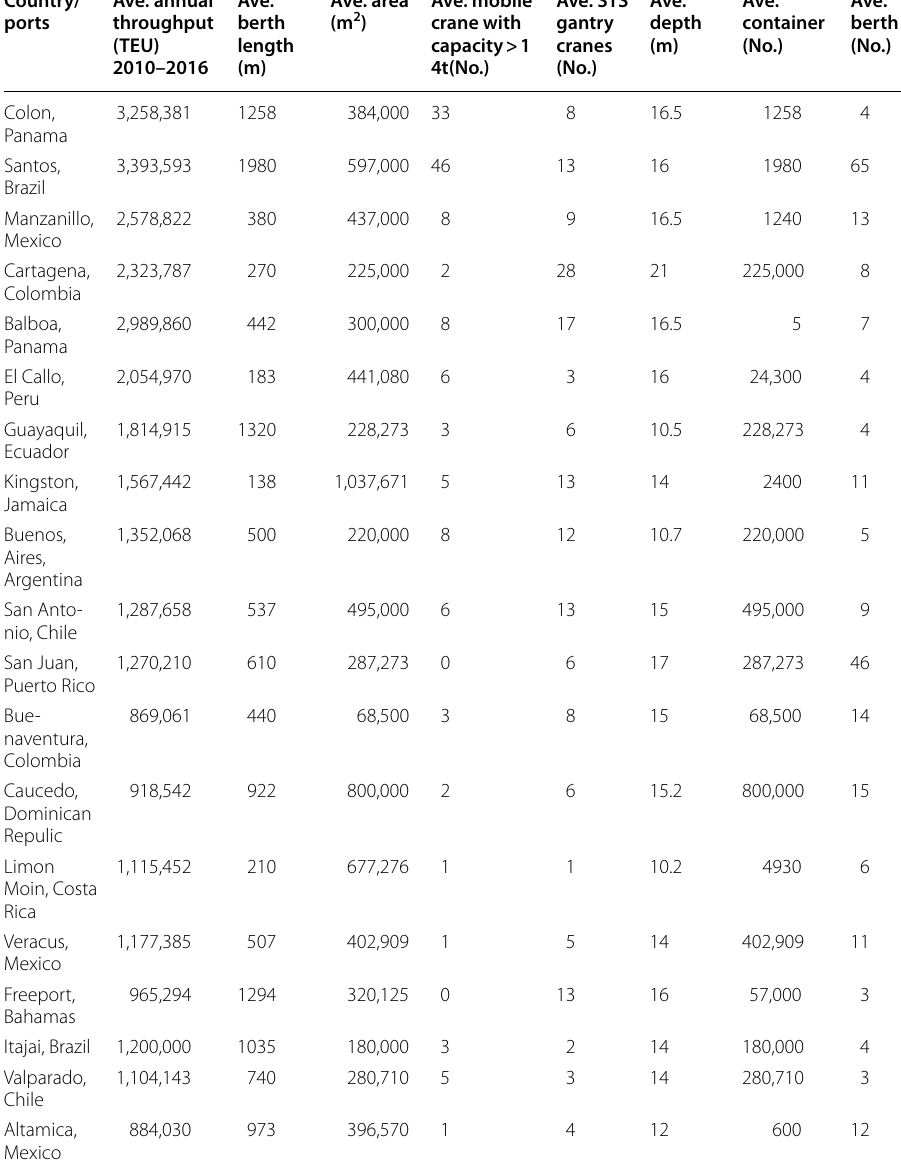
Table 11 Port characteristics. Average between 2000 and 2016. Source : Own elaboration based on data from World Port Source Country/